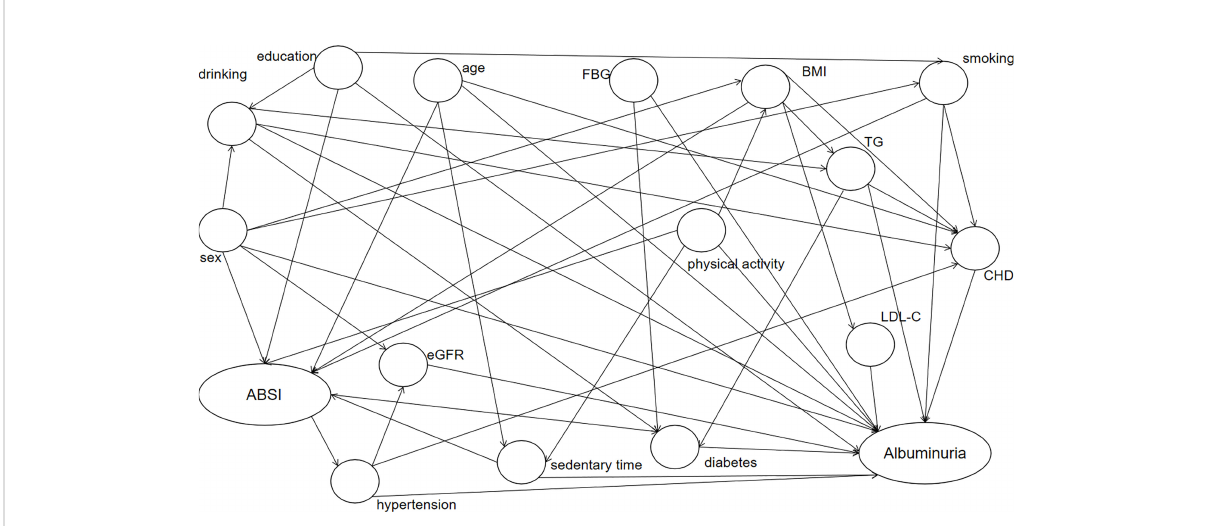
FIGURE 2 DAG diagram of the ABSI and albuminuria association study. Elliptic nodes represent independent variables ABSI and dependent variables albuminuria, circular nodes indicate possible confounders, and arrows indicate causality. ABSI, A Body Shape Index; BMI, body mass index; TG, triglycerides; LDL-C, low-density lipoprotein cholesterol; CHD, coronary heart disease; eGFR, estimated glomerular fi ltration rate.